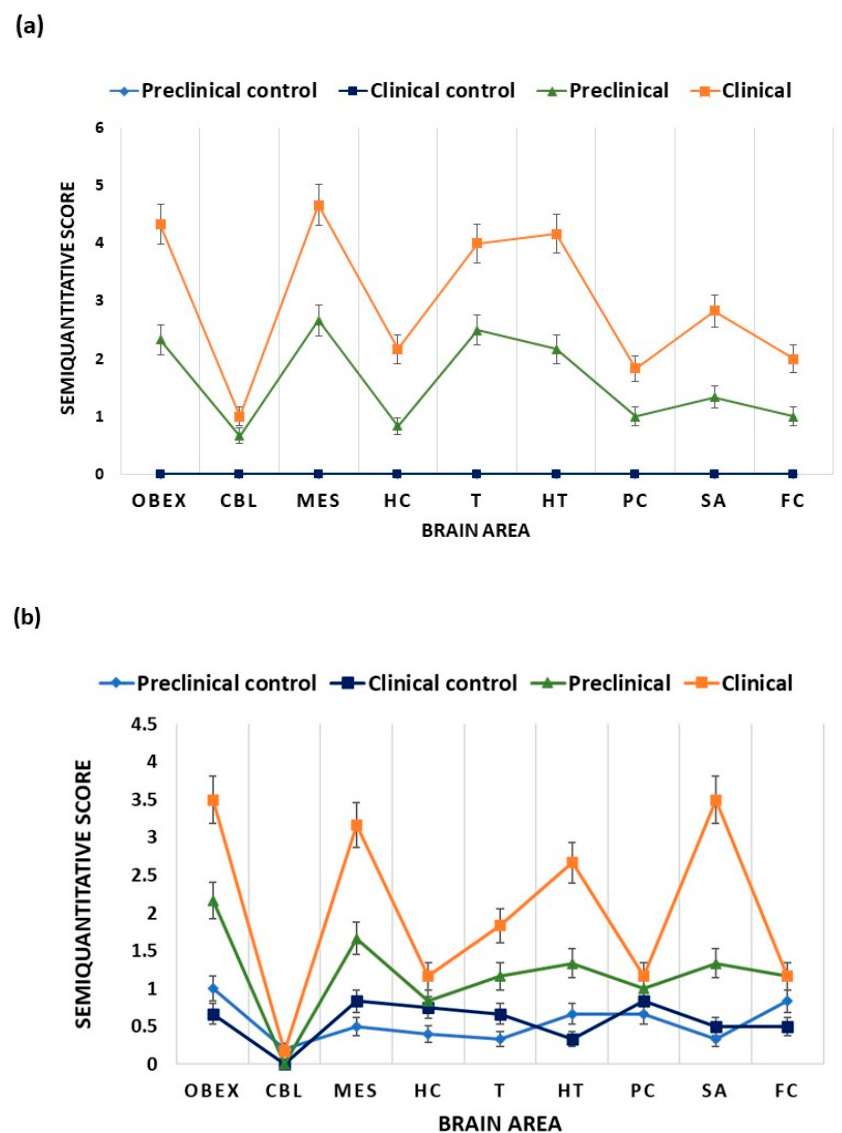
Figure 1. Semiquantitative evaluation in Tg338 mice of ( a ) PrP Sc deposits and ( b ) vacuolation on a semiquantitative scale being 0 for lack of staining/vacuolation and 5 for the staining/vacuolation present at maximum intensity. In ( a ) preclinical control and clinical control display the same levels of PrP Sc deposits. Data are shown as mean values ± SEM in the following brain areas: OBEX, cerebellum (CBL), mesencephalon (MES), hippocampus (HC), thalamus (T), hypothalamus (HT), parietal cortex (PC), septal area/striatum (SA), and frontal cortex (FC). The scrapie characterization of the sheep used in this study was performed previously in an earlier publication from our group